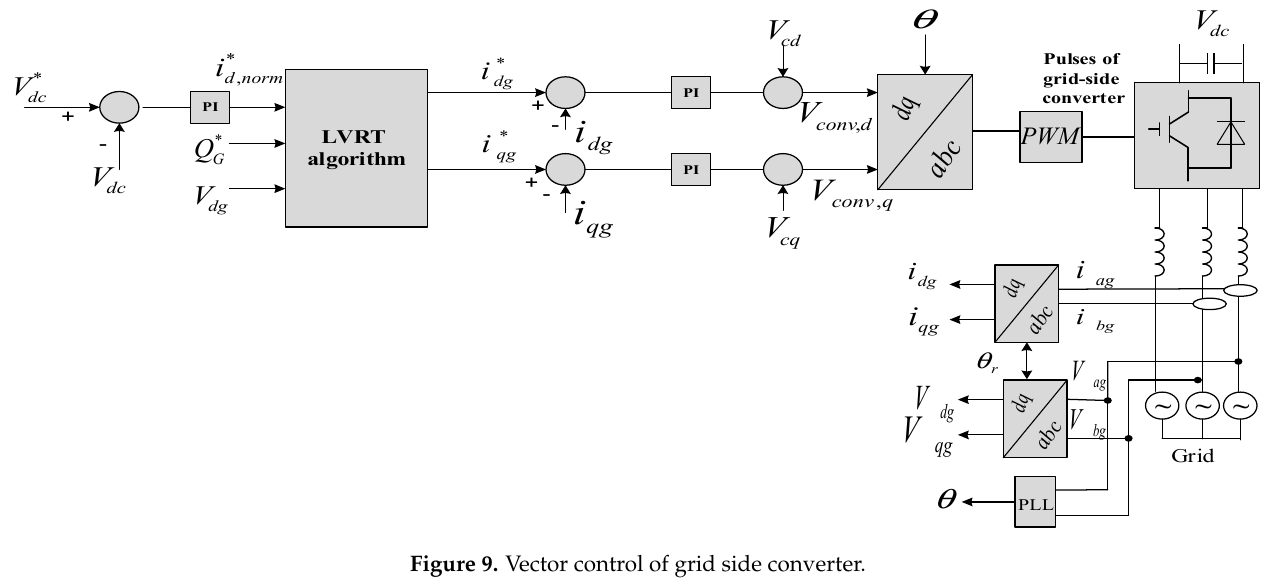
Figure 9. Vector control of grid side converter.